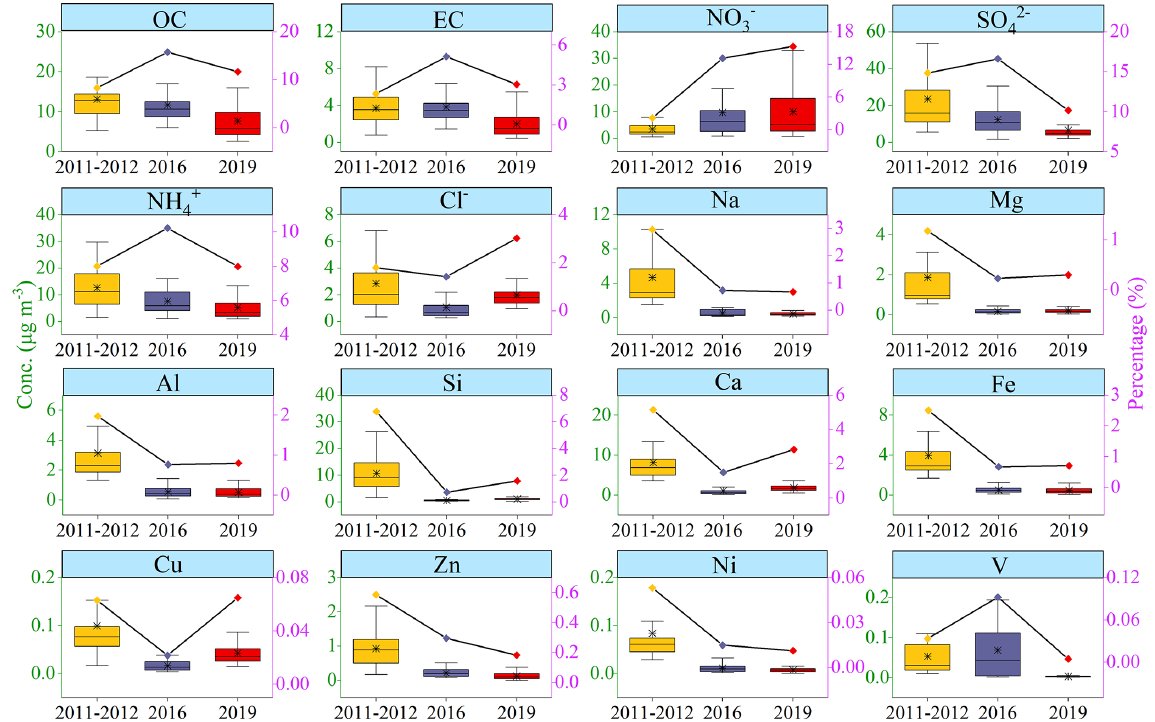
Figure 4. Variations in the average concentrations and percentages of major chemical compositions of PM 2 . 5 in 2011–2012, 2016, and 2019. Box charts represent concentrations, and line charts represent percentages.